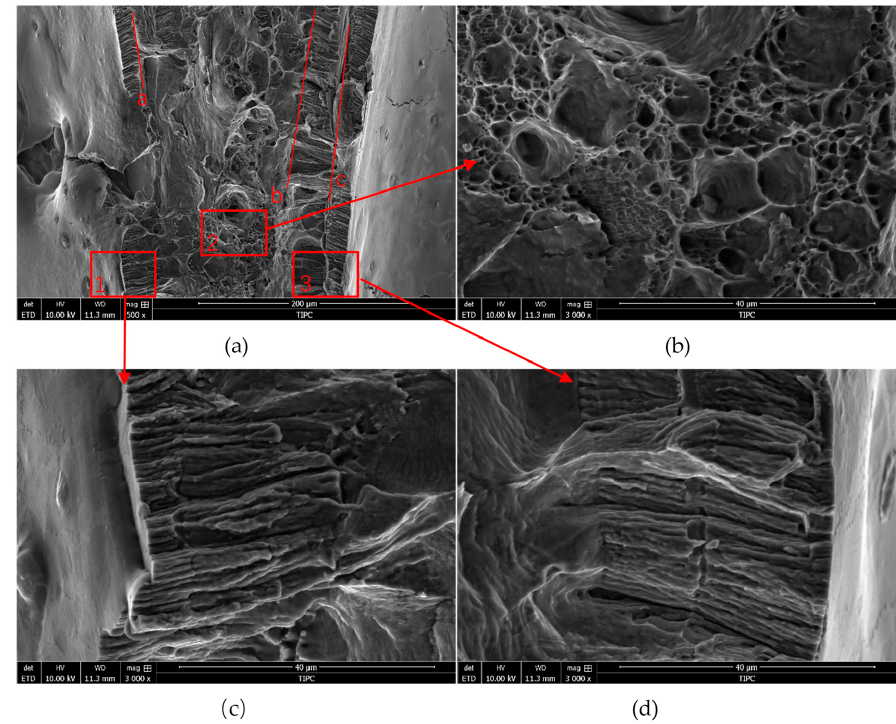
Figure 5. SEM images of millisecond laser ablation of aluminum alloy fractures. ( a ) is the 500× magnified image of the fracture, ( b ) is the 3000× magnified image of zone 2, ( c ) is the 3000× magnified image of zone 1, and ( d ) is the 3000× magnified image of zone 3. The lines corresponding to letters a, b and c are the demarcation lines between the two morphologies.